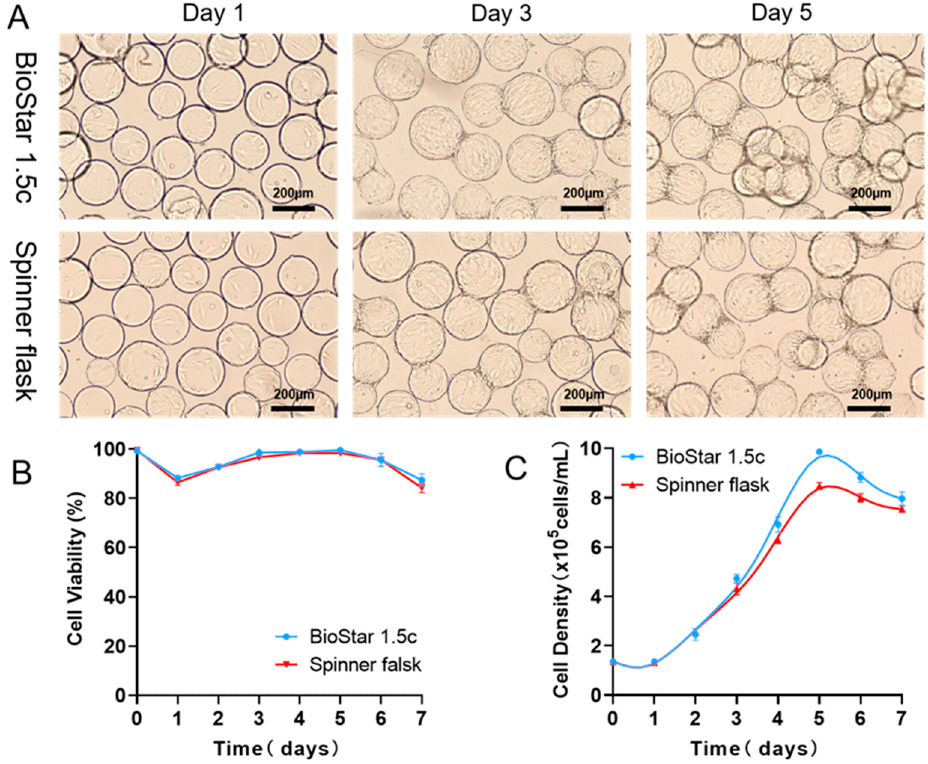
Figure 4. ( A ) Morphology and distribution of batch-cultured hUCMSCs on microcarriers at different time points (Day 1 to Day 7) cultured in both BioStar 1.5c and the spinner flask. ( B , C ) Cell viability and density during expansion of hUCMSCs. Data expressed as the mean ± standard deviation ( n = 4 per group, per time point).